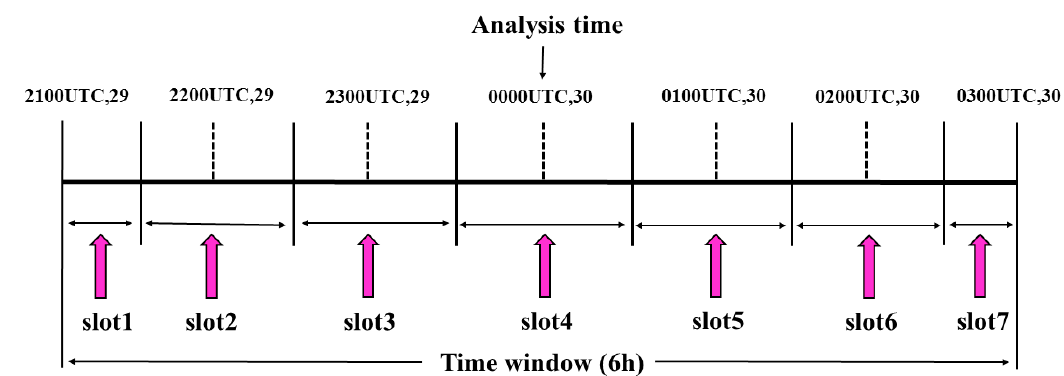
Figure 2. The sub-windows in the satellite data assimilation time window. See text for details.